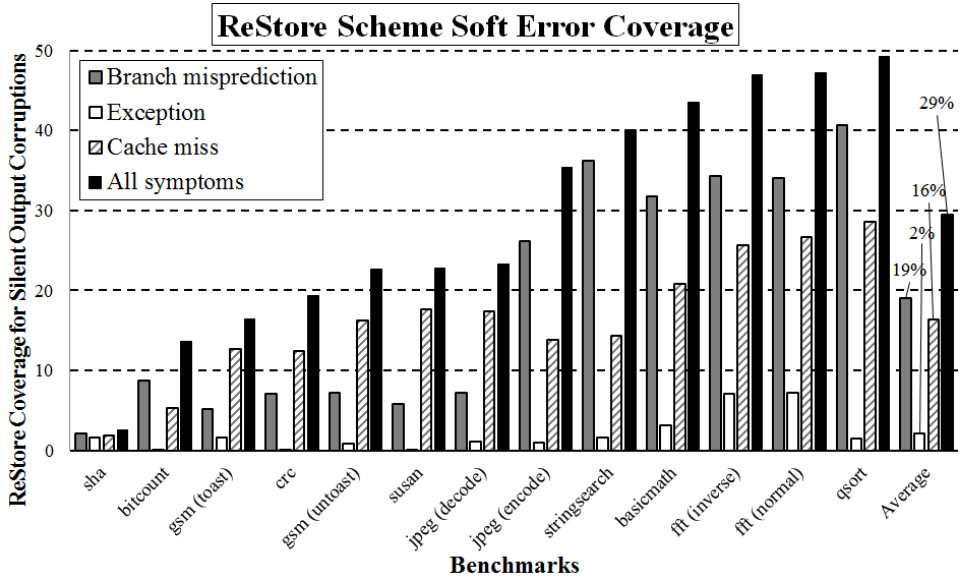
Figure 3. ReStore architecture can recover just 29% of user-visible failures while considering branch mispredictions, cache misses, and exceptions as symptoms and a recovery window of 100 instructions on